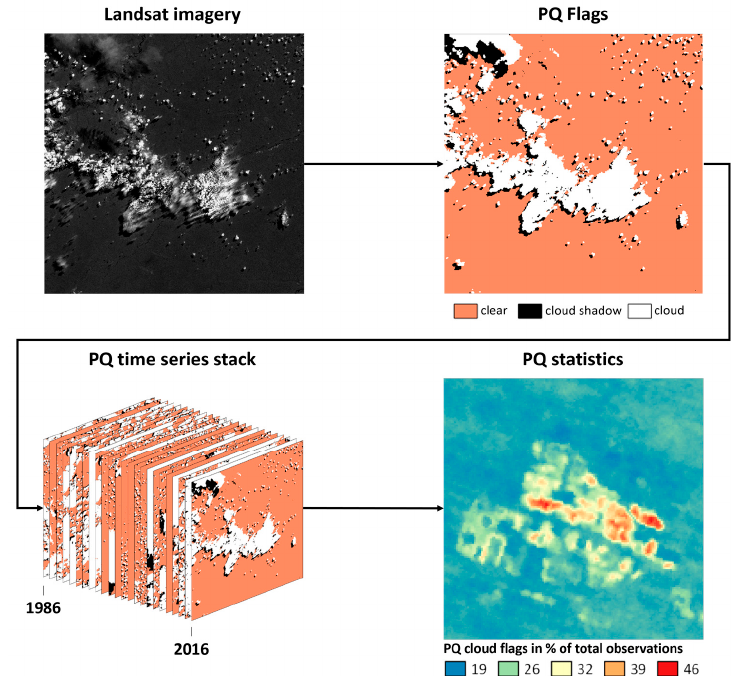
Figure 1. Extracting information about how often a pixel was affected by clouds in 31 years from 1986 to 2016: For each individual Landsat observation we derive PQ flags and combine them into a PQ time series stack. This stack is then summarized as a single layer, reflecting how many times a pixel was flagged as cloud. The result is normalized by the number of total observations per